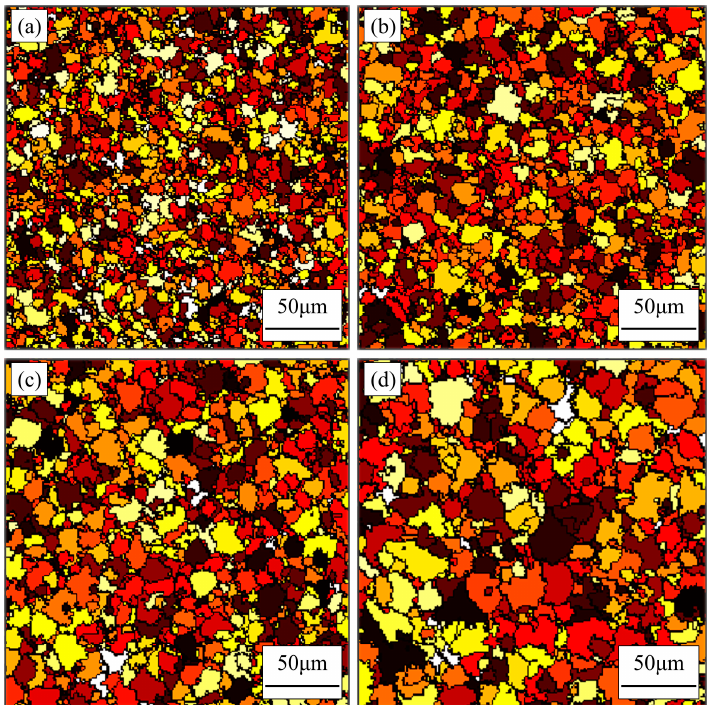
Figure 3. Microstructures of FeMnSiCrNi SMA undergoing compression ( ε 0.5 s − 1 , ε 0.9 ) based on CA simulation: ( a ) T = 850 °C; ( b ) T = 900 °C; ( c ) T = 950 °C; ( d ) T = 1000 °C.